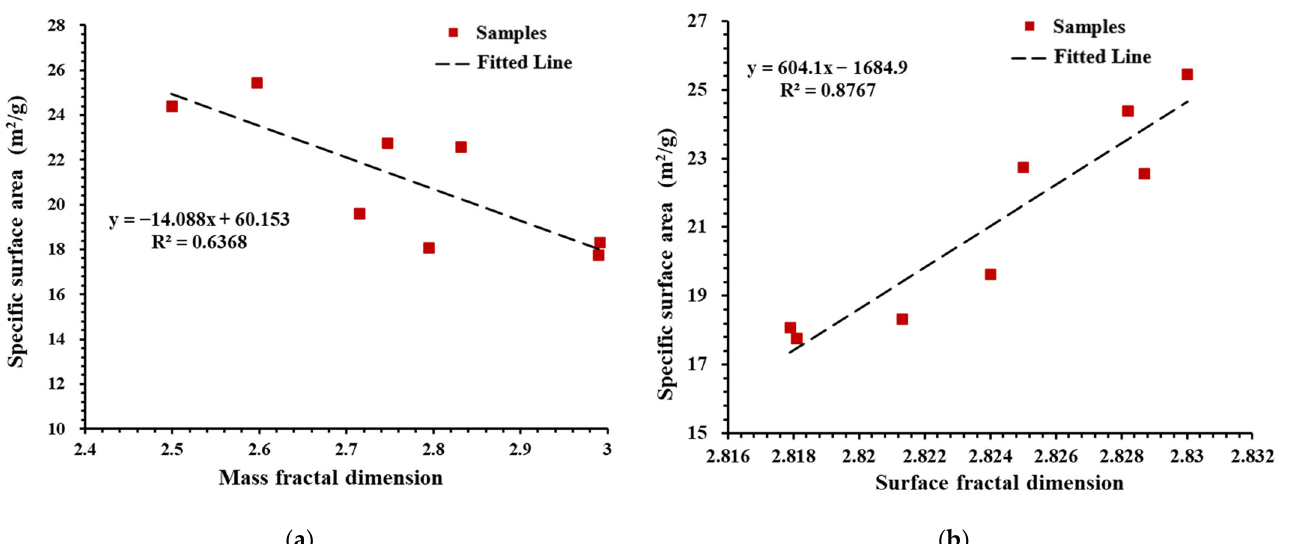
Figure 11. ( a ) Relationship between the mass fractal dimension and specific surface area of the deep shale samples. ( b ) Relationship between the surface fractal dimension and specific surface area of the deep shale samples.